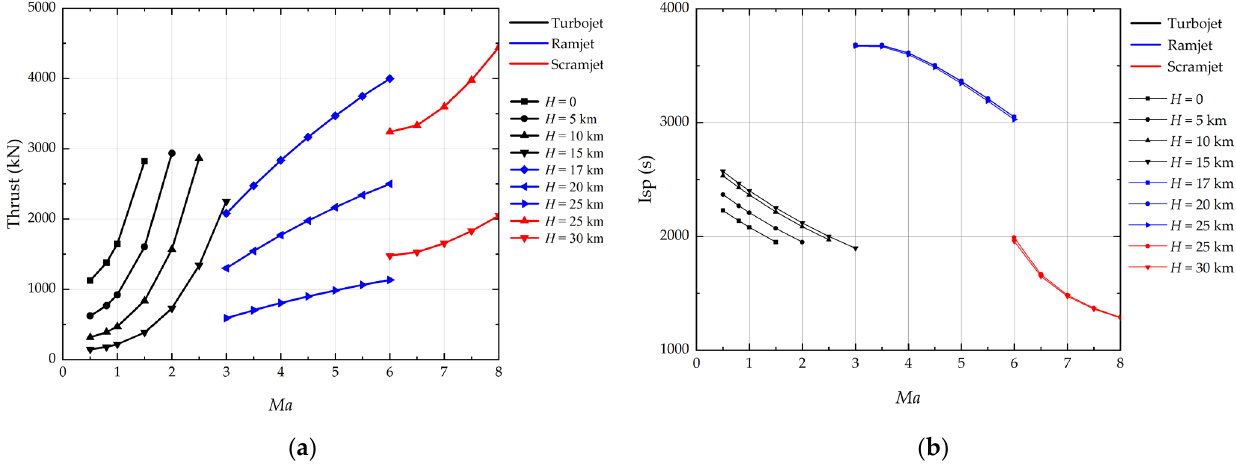
Figure 6. Thrust and specific impulse of the TBCC engine. ( a ) Thrust curves; ( b ) specific impulse